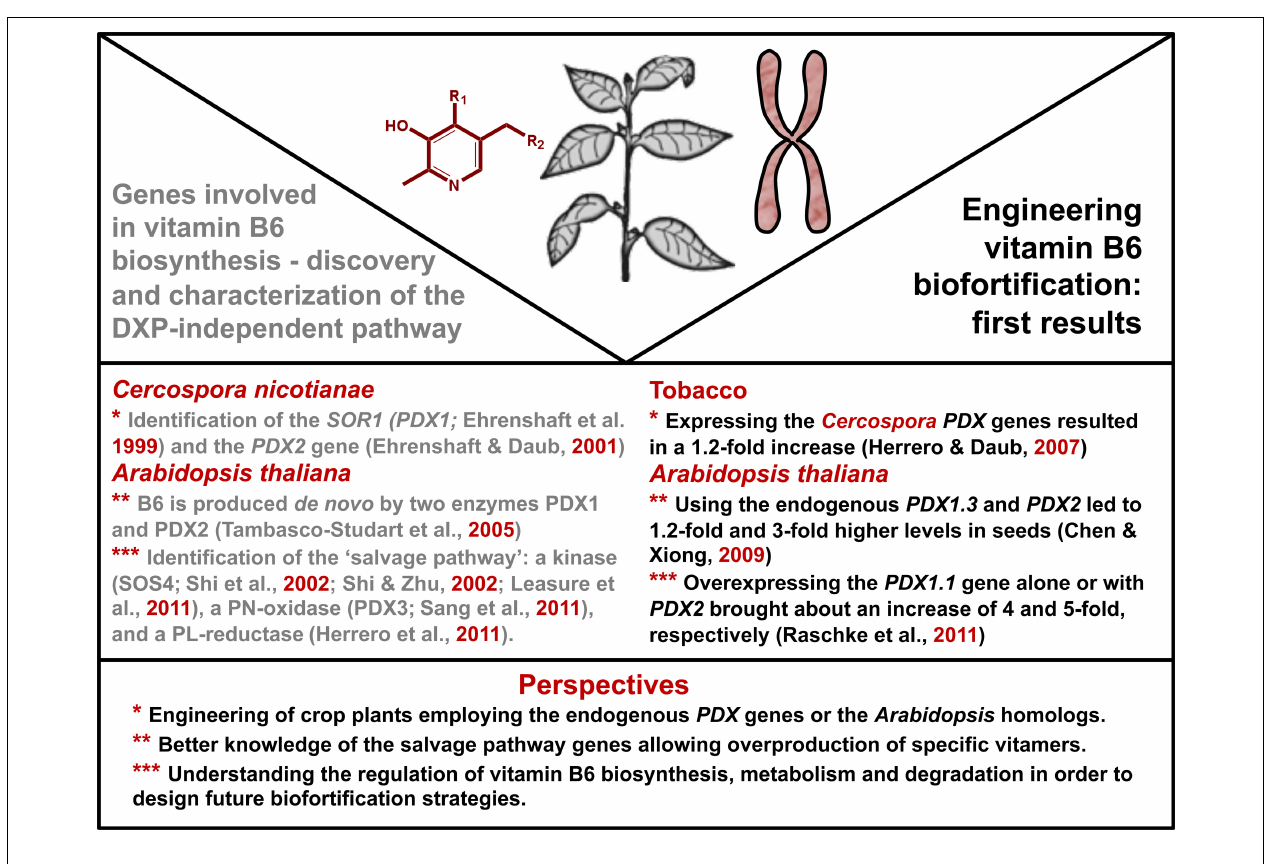
FIGURE 2 | Summary of the genetic approaches used in unraveling the deoxyxylulose 5-phosphate (DXP)-independent pathway for vitamin B6 biosynthesis de novo and first proof-of-principle strategies for vitamin